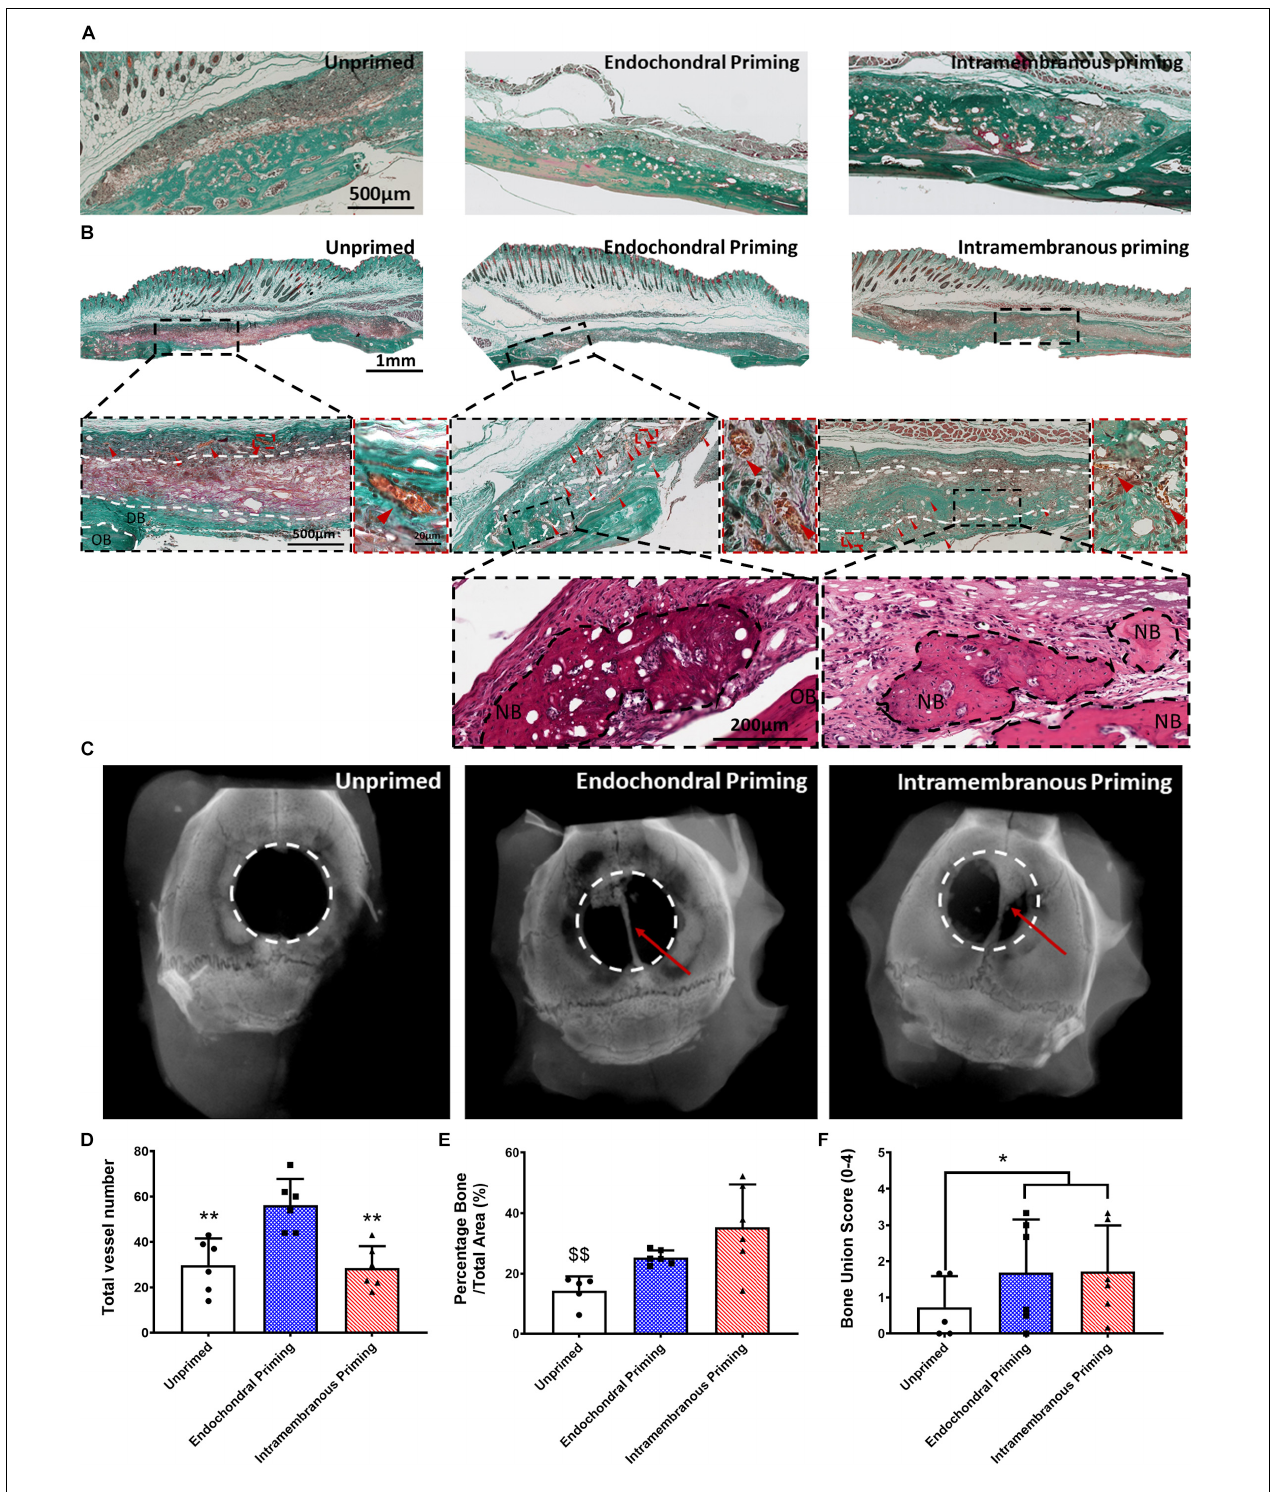
FIGURE 2 | (A) Masson’s Trichrome stained sections of all groups after 8 weeks in vivo, showing the osteoconductive nature of the scaffolds. (B) Masson’s Trichrome and H&E stained sections of all groups taken in the middle of the defect after 8 weeks in vivo. All Images taken at 20X. White dashed lines denoting periphery and center, OB denoted original bone, and NB denotes new bone. Red arrow heads denote vessels. (C) Representative X-ray images of the three experimental groups 8 weeks after implantation. Quantification of the amount of panel (D) total number of vessels, (E) percentage new bone, and (F) bone union score for all three experimental groups 8 weeks post implantation. Error bars denote standard deviation, ** p < 0.01 vs. Endochondral Priming group, $$ p < 0.01 vs. Intramembranous Priming group, n = 6 animals.